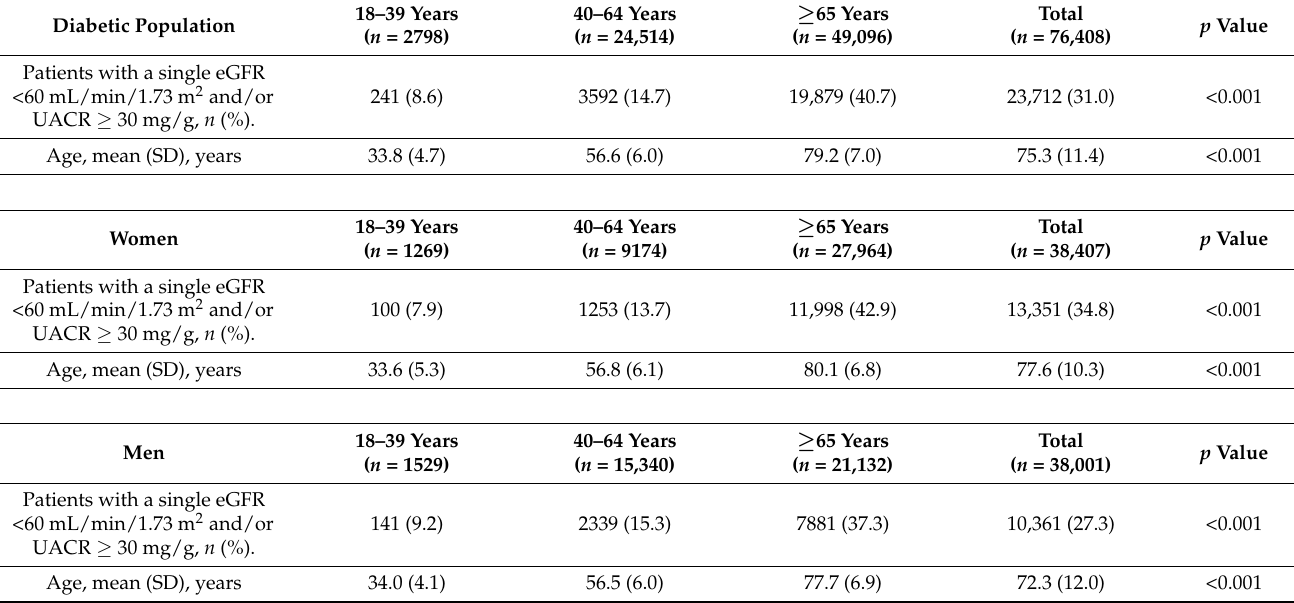
Table 3. Distribution of the diabetic population that underwent only a single test of eGFR and/or UACR. ≥ 65 Years 18–39 Years 40–64 Years Total p Value Diabetic Population ( n = 2798) ( n = 24,514) ( n = 49,096) ( n = 76,408) Patients with a single eGFR <60 mL/min/1.73 m 2 and/or 241 (8.6) 3592 (14.7) 19,879 (40.7) 23,712 (31.0) <0.001 UACR ≥ 30 mg/g, n (%). Age, mean (SD), years 33.8 (4.7) 56.6 (6.0) 79.2 (7.0) 75.3 (11.4)